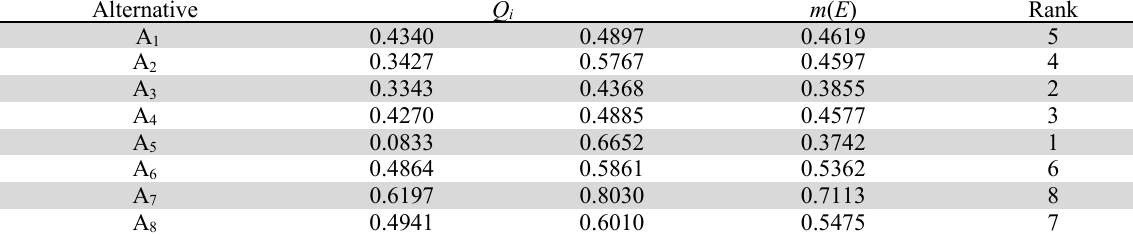
Q interval numbers and mid-point m ( E ) values with rank Alternative